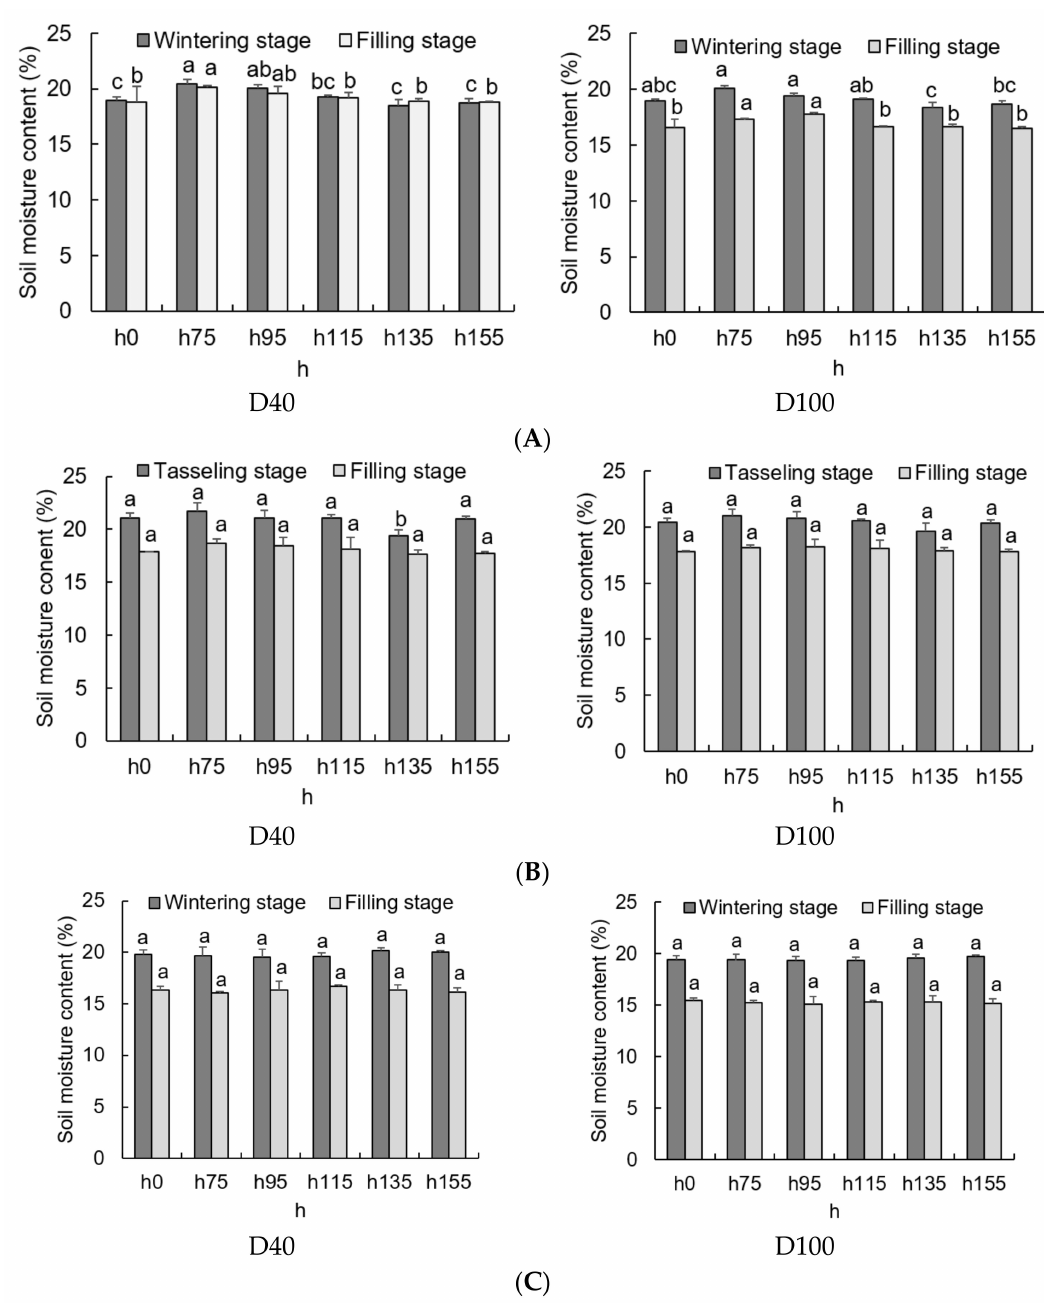
Figure 6. Mean soil moisture content for winter wheat in the first growing season (WW1) ( A ), summer maize (SM) ( B ), and winter wheat in the second growing season (WW2) ( C ). (D40 and D100 stand for mean soil moisture contents of top 40 cm and top 100 cm soils, respectively; different letters (a–c) stand for significant difference at p < 0.05; error bars represent standard deviations from the